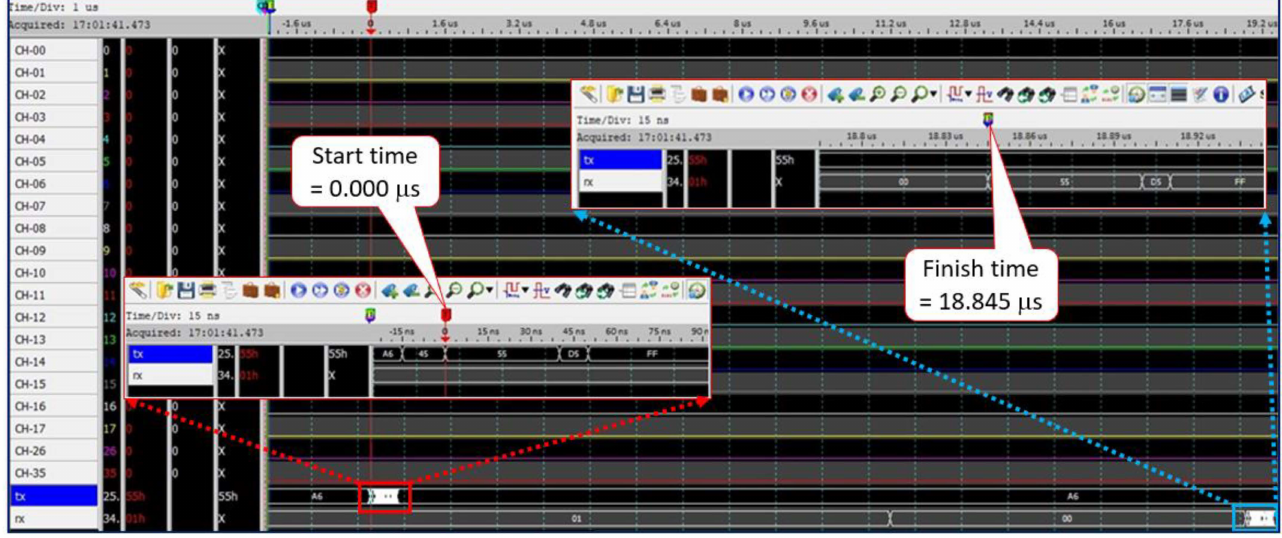
Figure 20. A latency of 18.845 µ s is measured for the transmission of the Ethernet Modbus TCP packets from start point (0.000 µ s) to finishing point (18.845 µ